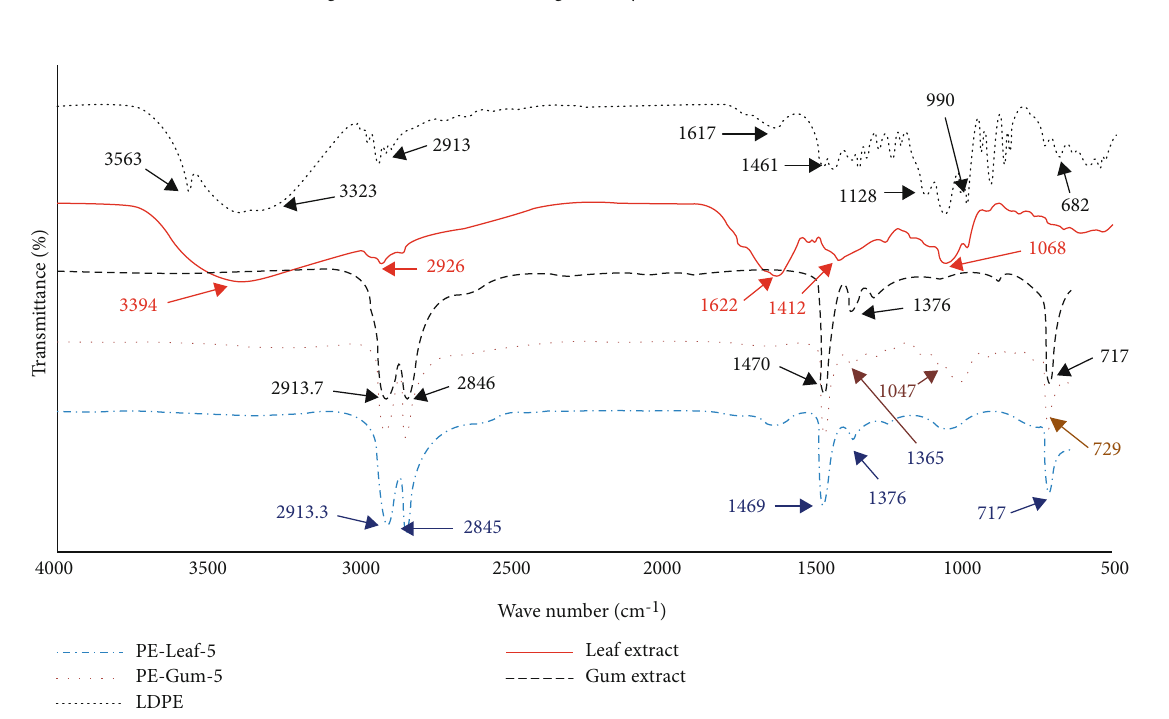
Figure 1: FTIR spectrum of leaf extract, gum extract, and active fi lms containing 5% extract in comparison with pure polyethylene fi